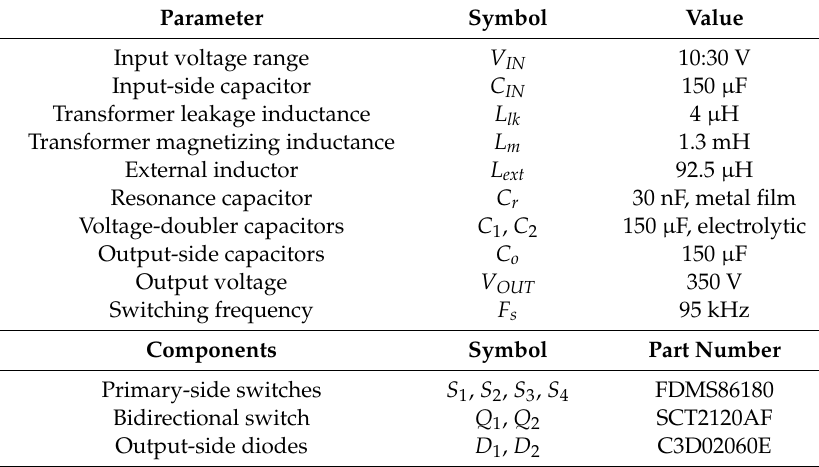
Table 1. Setup parameters and components.